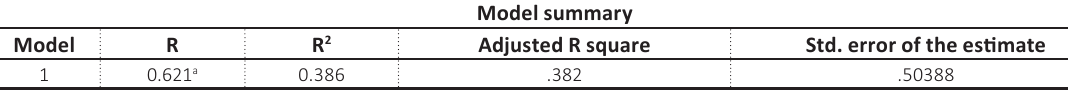
Table 6. Results of simple linear regression for H01